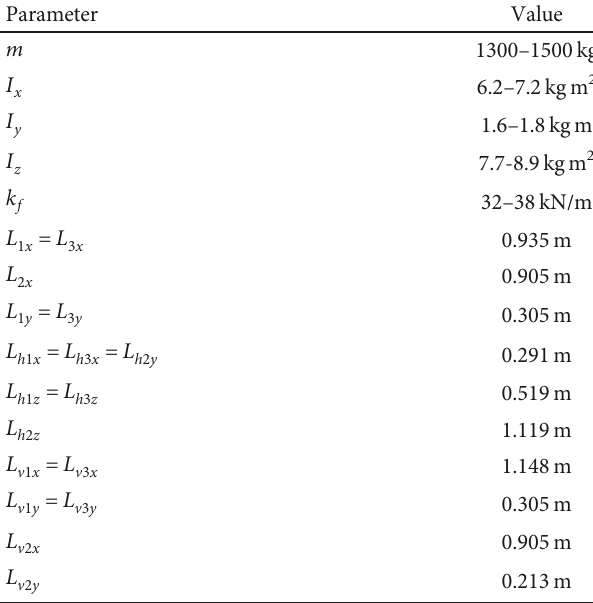
Table 1: Parameters of the